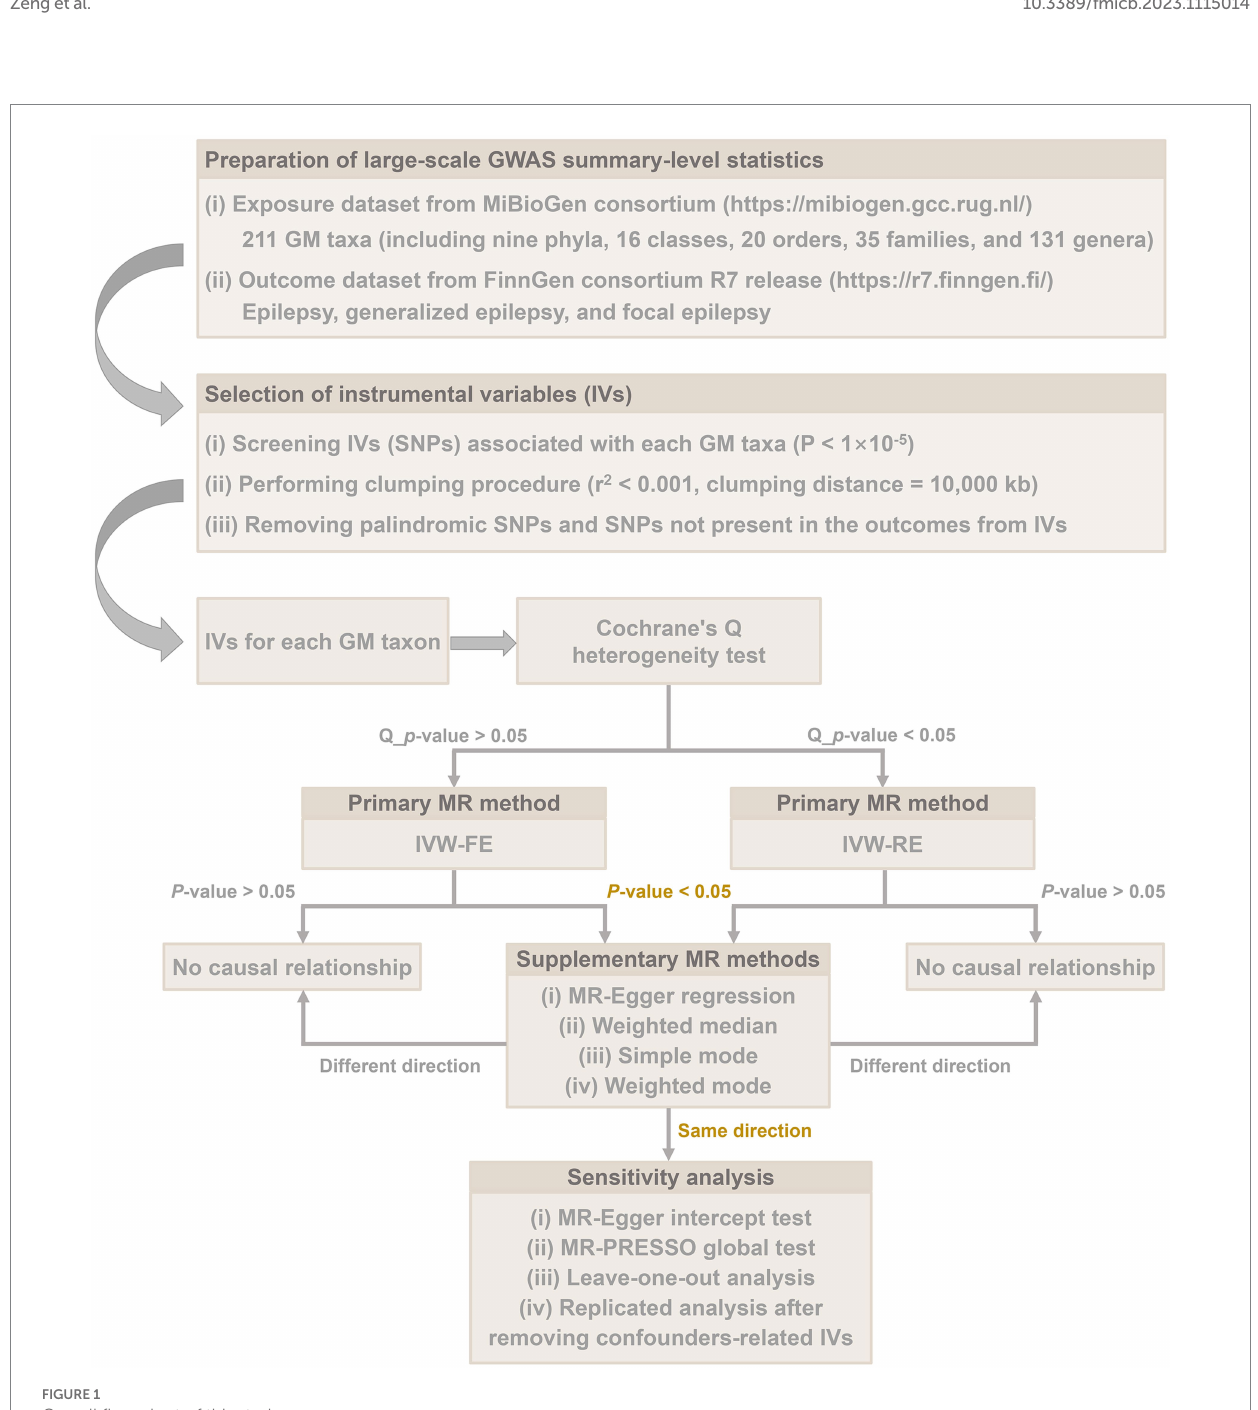
FIGURE 1 Overall flow chart of this study.